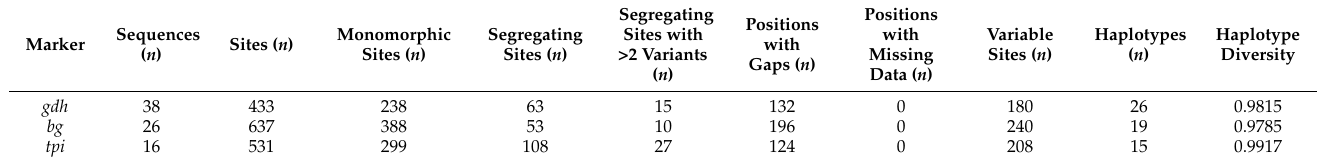
Table 4. Haplotypes distribution for gdh , bg, and tpi